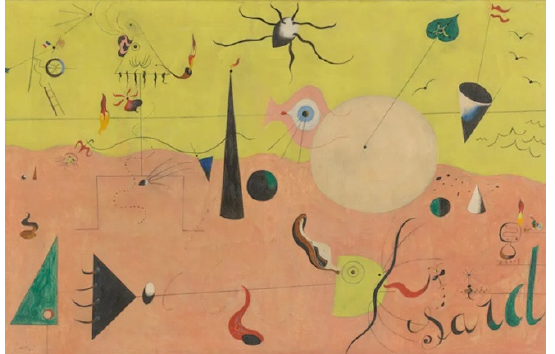
Figure 9. Joan Miró, The Hunter (Catalan Landscape), 1923 – 1924 . Licensed under Creative Com- Figure 9. Joan Mir ó , The Hunter (Catalan Landscape), 1923–1924. Licensed under Creative Commons: mons: CC BY-ND 2.0 . CC BY-ND